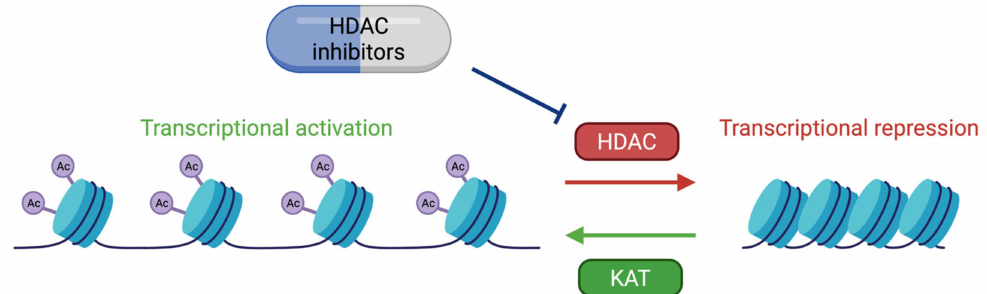
Figure 5. Therapeutic approach by HDAC inhibitors (HDACi). The action of the KAT proteins is antagonized by HDAC proteins allowing a dynamic regulation of the chromatin structure and the gene expression. Acetyl transferase deficiency can be compensated by HDAC inhibitors. HDACi tested in different RSTS mouse and in lymphoblastoid cell lines derived from RSTS patients rescue deficits in histone acetylation, particularly in H2A and H2B. HDACi represent a therapeutic option for improving intellectual efficiency in RSTS patients but have to be evaluated in clinical